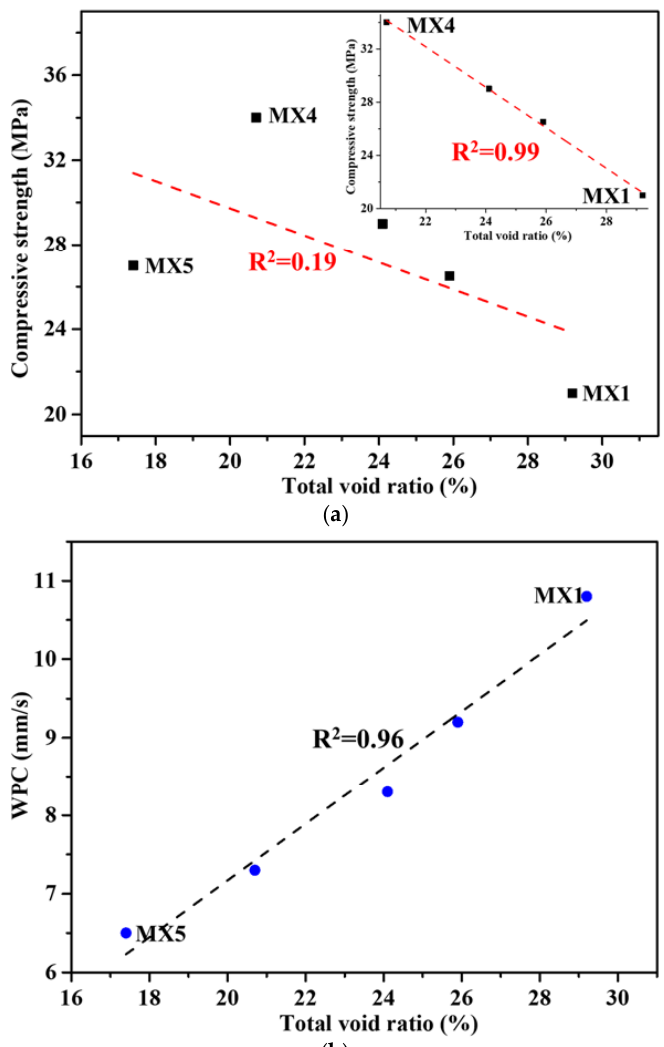
Figure 3. Correlation between ( a ) mean compression strength and total void ratio (inlet is the correlation neglecting MX5); ( b ) WPC and total void ratio.